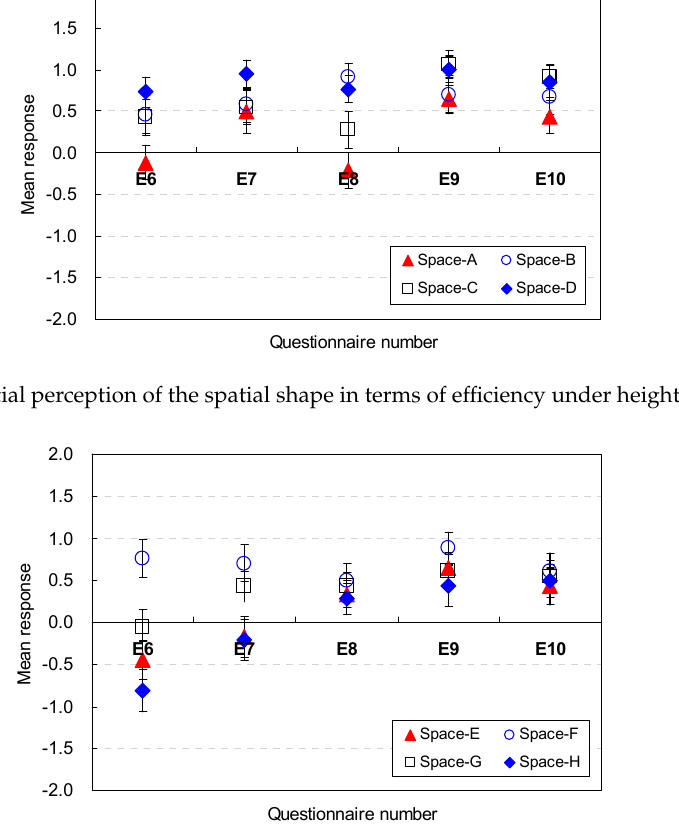
Figure 15. Spatial perception of the spatial shape in terms of efficiency under floor layout changes. For Spaces E, F, G, and H, the rectangular shape that had a wider width and a shallower depth (Space F) provided positive perceptions of efficiency (M = 1.30, SD = 0.21). This result indicates that